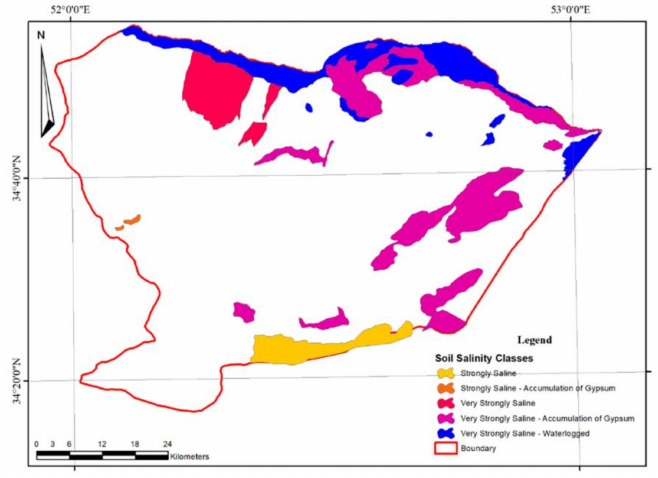
Figure 10. Soil salinity map of the study area as a constraining factor.